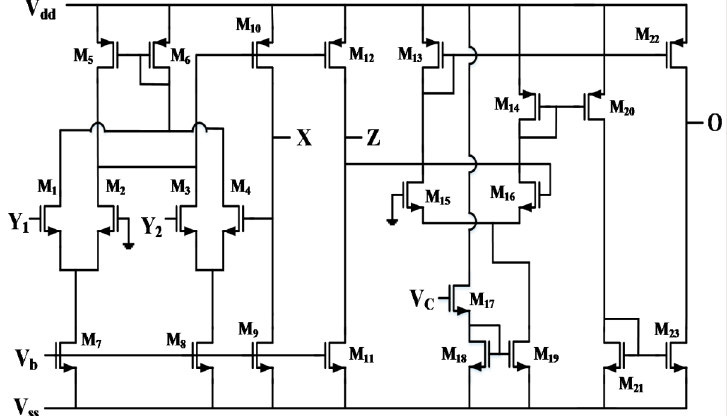
Figure 2. Internal structure of CMOS based DVCCTA.